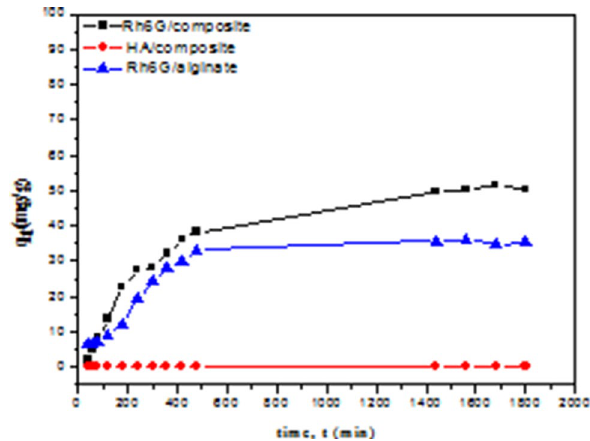
Fig. 6 Kinetic adsorption data for Rh6G and HA in single compo- nent systems on composite and alginate ( C 0 = 100 mg/cm 3 , T = 20 °C,